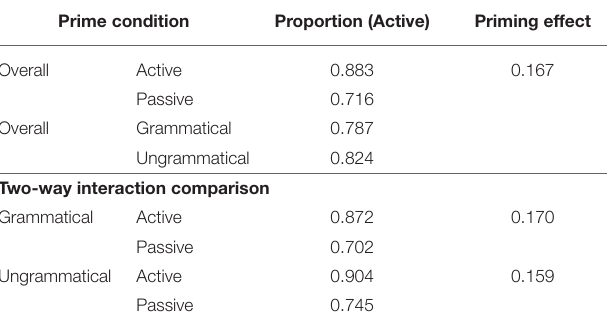
TABLE 3.1 | Experiment 1 proportion